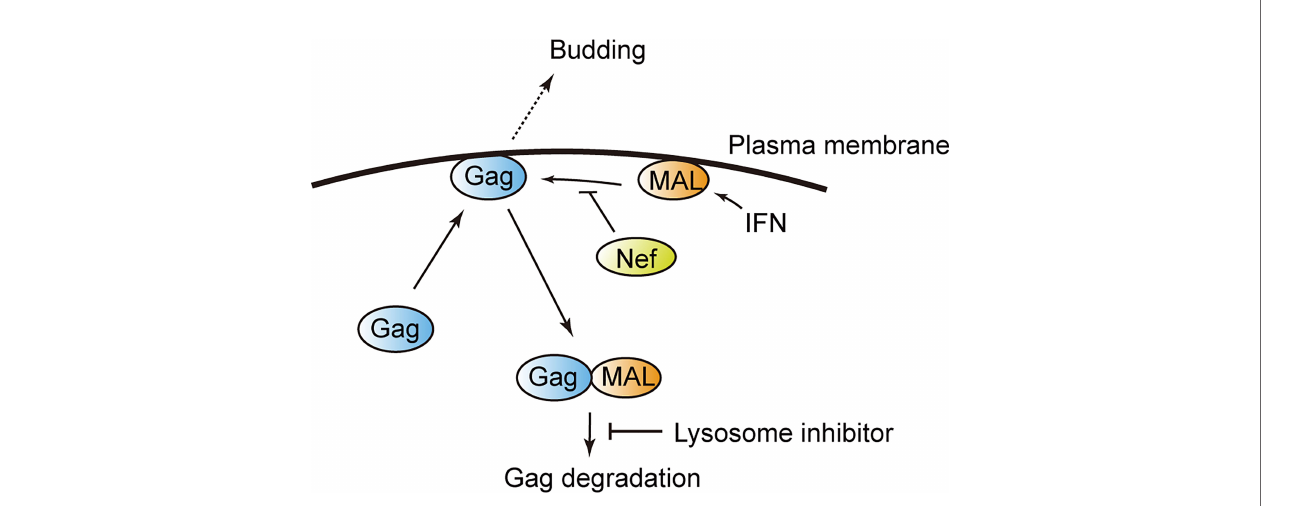
FIGURE 7 | Model illustrating MAL-induced Gag degradation. MAL targets the matrix domain of the HIV-1 Gag protein and induces its degradation via the endolysosomal pathway. The viral protein Nef inhibits this interaction, overcoming the antiviral activity of